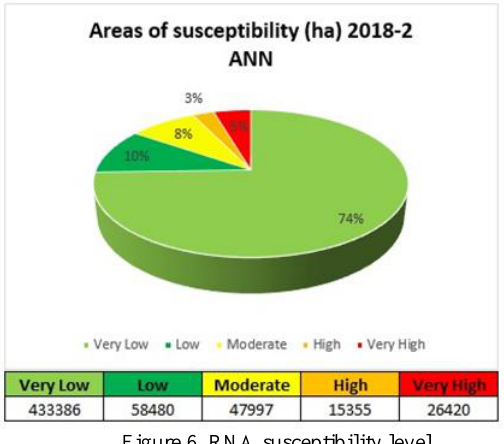
Figure 6. RNA susceptibility